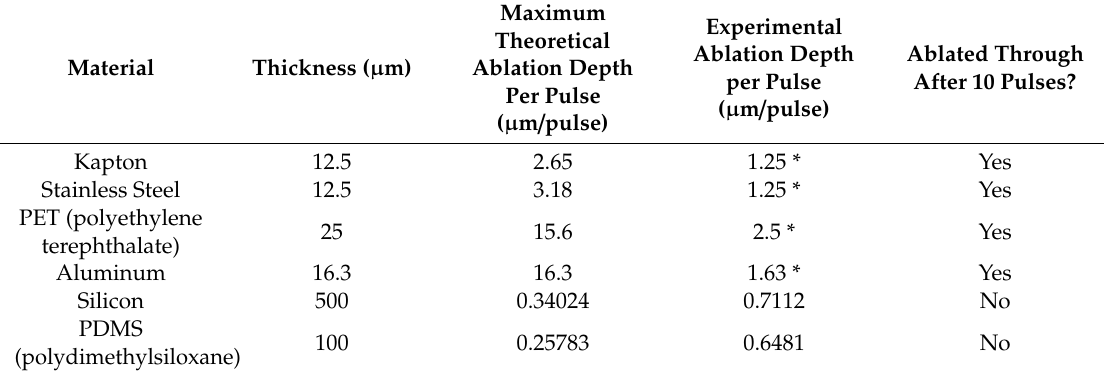
Table 1. Comparison of theoretical and experimental ablation